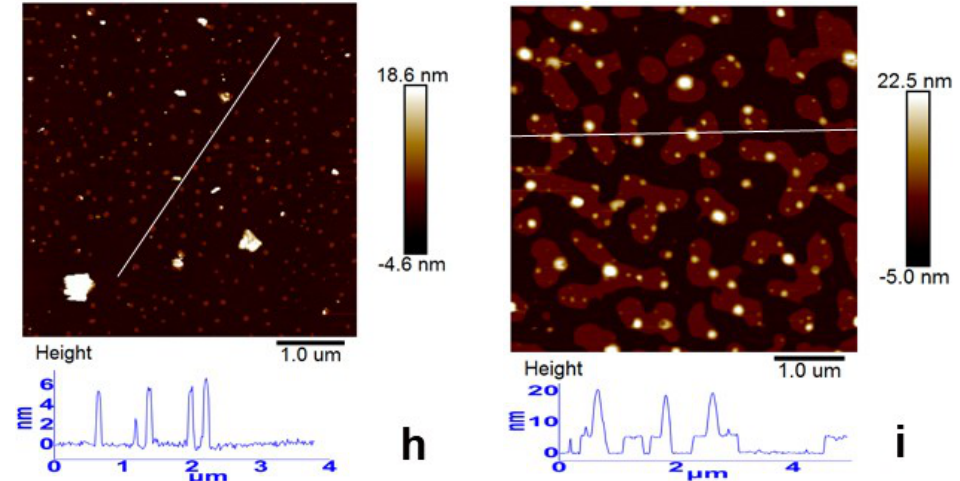
Figure 5. AFM image of RGO (( b ) ORGO at 35 °C, 0.5 h; ( c ) ORGO at 35 °C, 5 h; ( d ) ORGO at 50 °C, 0.5 h; ( e ) ORGO at 50 °C, 5 h; ( f ) ORGO at 80 °C, 0.5 h; ( g ) ORGO at 80 °C, 5 h; ( h ) ORGO at 120 °C, 0.5 h; ( i ) ORGO at 120 °C, 5 h).